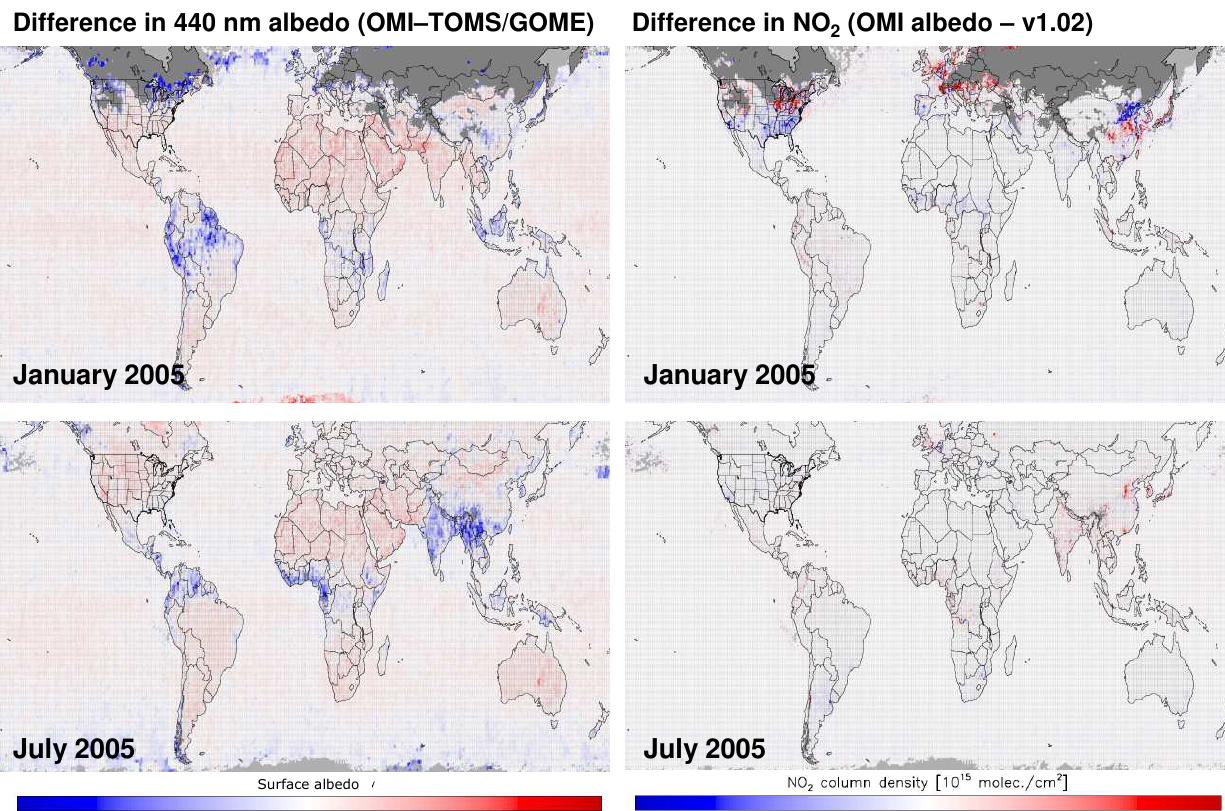
Fig. 4. Left column: difference in surface albedo between OMI and TOMS-GOME (440 nm) for January and July 2005. Right column: difference (OMI - v1.02) in retrieved tropospheric NO 2 columns from the DOMINO algorithm calculated with different surface albedo climatologies (v1.02: TOMS-GOME, improved algorithm: OMI). Only scenes with cloud radiance fractions smaller than 0.5 have been selected, and scenes with snow or ice have been excluded.